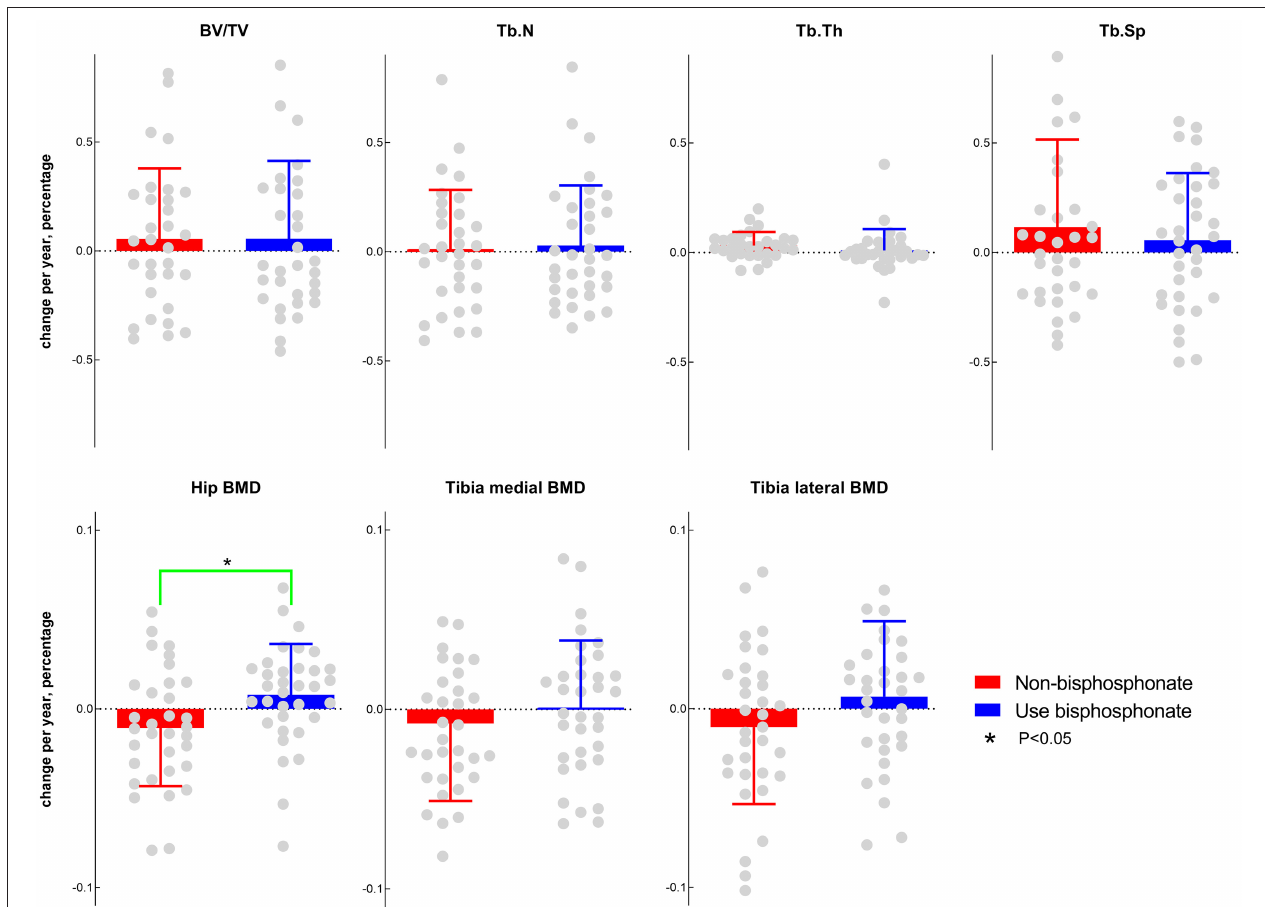
FIGURE 3 | Comparisons of subchondral bone morphometry and BMD between the bisphosphonate current-use (in the previous 30 days) group and the non-bisphosphonate